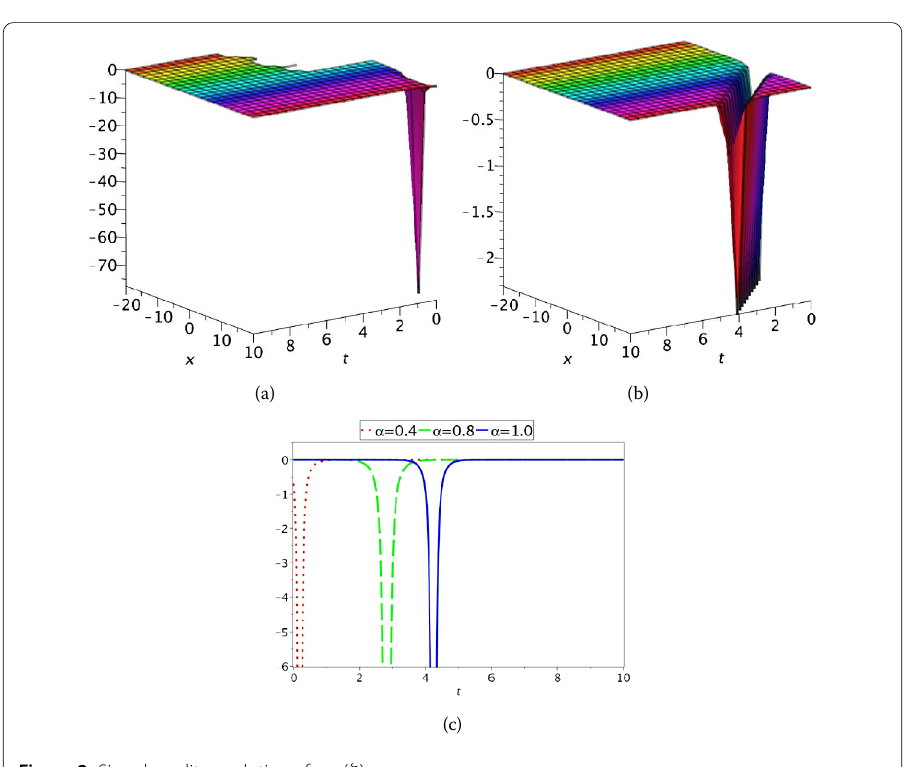
Figure 2 Singular soliton solution of u 1,2 ( ξ